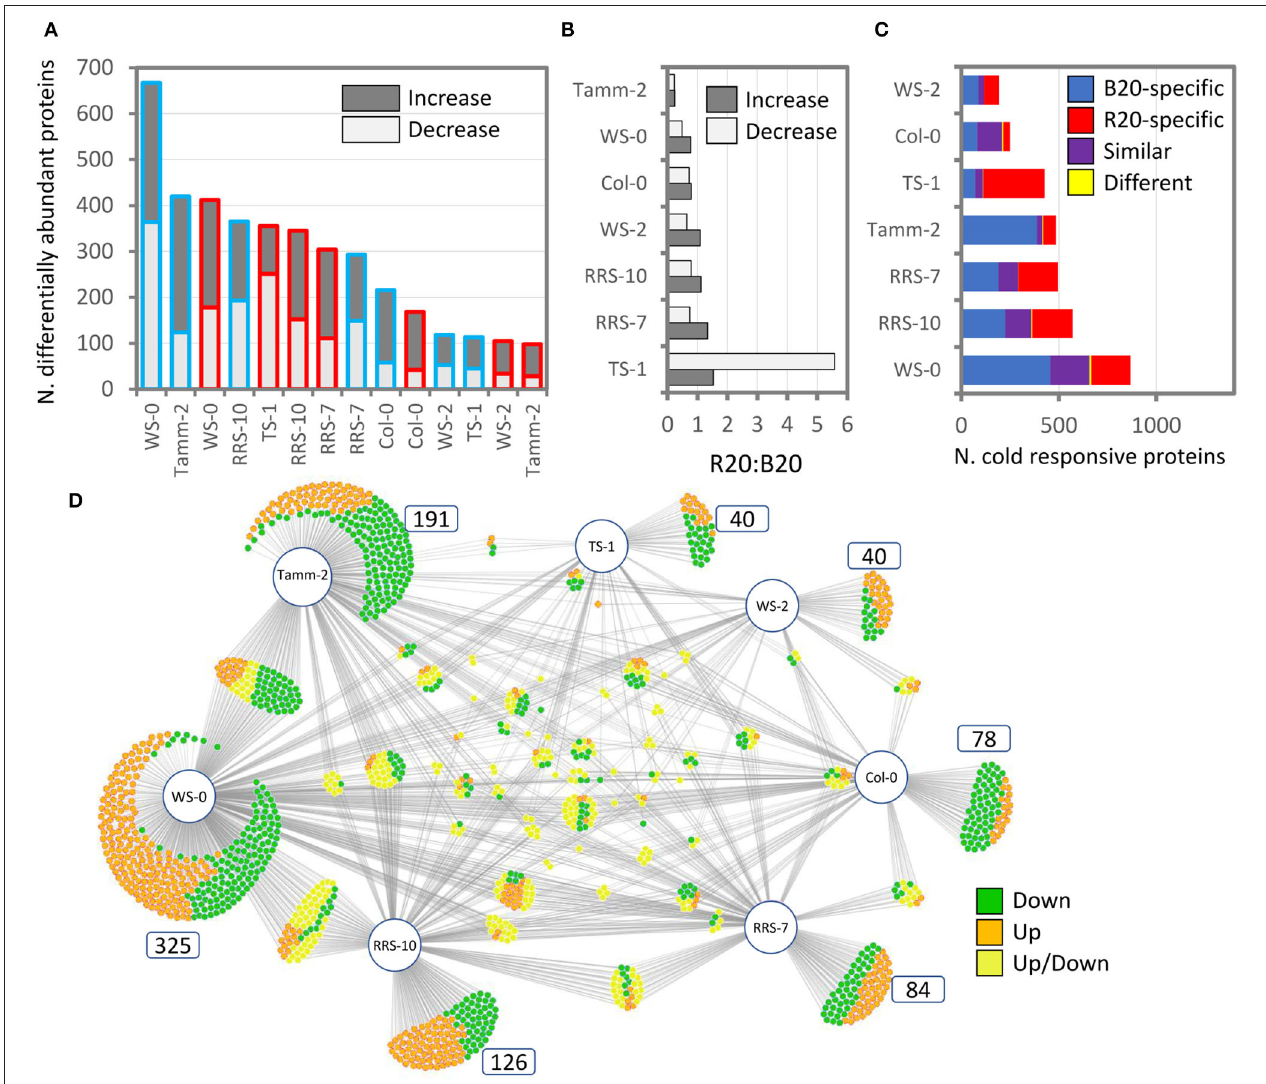
FIGURE 6 | Comparison of cold stress response in Arabidopsis accessions. (A) Differentially abundant proteins in leaf proteomes of plants grown under red (R20; red outline) or blue (B20; blue outline) light at 4 ◦ C for 7 days compared to respective accessions grown under standard conditions (21 ◦ C, W100). (B) Comparison of ratios between the number of cold-responsive proteins in R20 vs. B20 plants. (C) Cold stress in R20 and B20 plants elicits unique sets of proteins. (D) The cold response is accession-specific. Comparison of response to cold stress in B20 plants visualized with DiVenn 2.0 (Sun et al., 2019). For details, see Supplementary Material S6